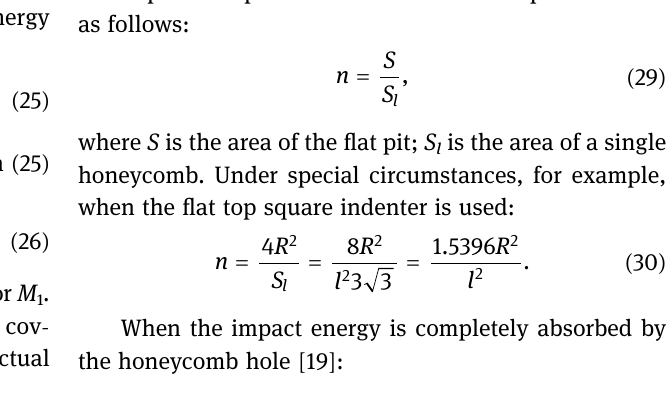
Table 1: Energy absorption of aluminum honeycomb structure Parameter S e ( kJ/kg ) S te Force stroke characteristic Aluminum honeycomb ( crushing